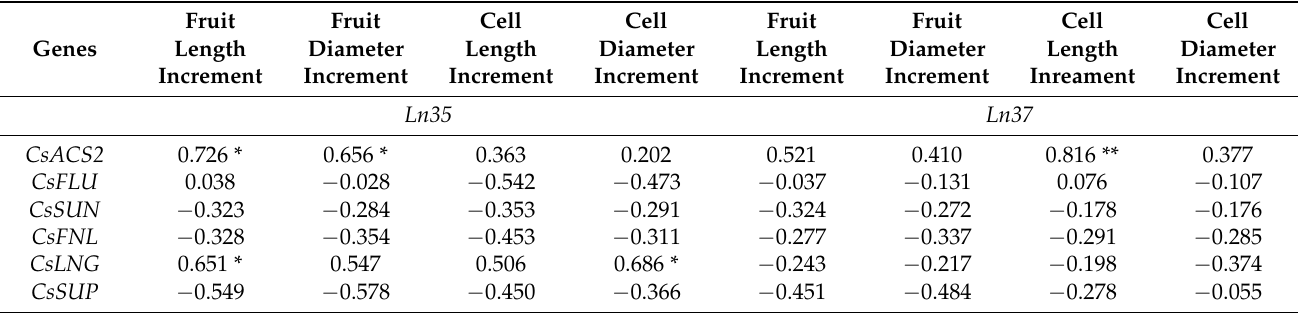
Figure 4. The relative expression of fruit shape genes in fruit development. 2.5. The Relationship between Cell Size and Fruit Shape and Size The relationships between the cell and fruit of Ln35 and Ln37 , respectively, were analyzed (Table 1). There were strong positive correlations between cell length and fruit length, cell diameter, and fruit diameter in both two lines, indicating that cell size influenced the fruit size in cucumbers. Table 1. The correlation analysis between gene expression, fruit increment, and cell increment.